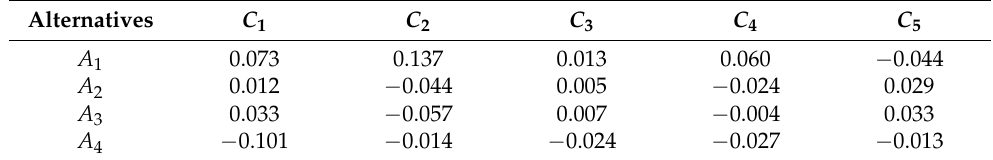
Table 5. The distance matrix D